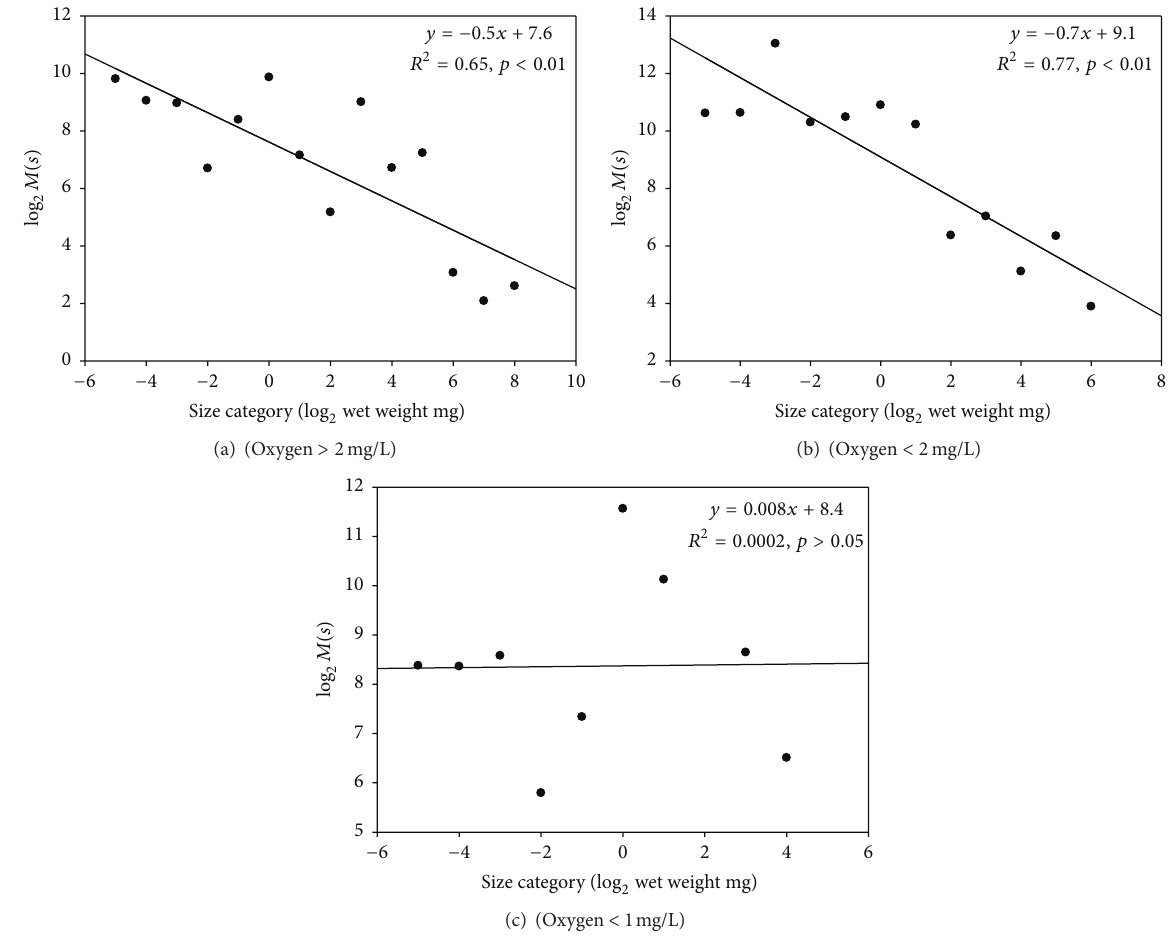
Figure 5: Normalized biomass size spectra (NBSS; see text) under different oxygen concentrations: (a) oxygen concentration > 2 mg/L; (b) < 2mg/L; and (c) < 1mg/L. Note the differences in axes in each